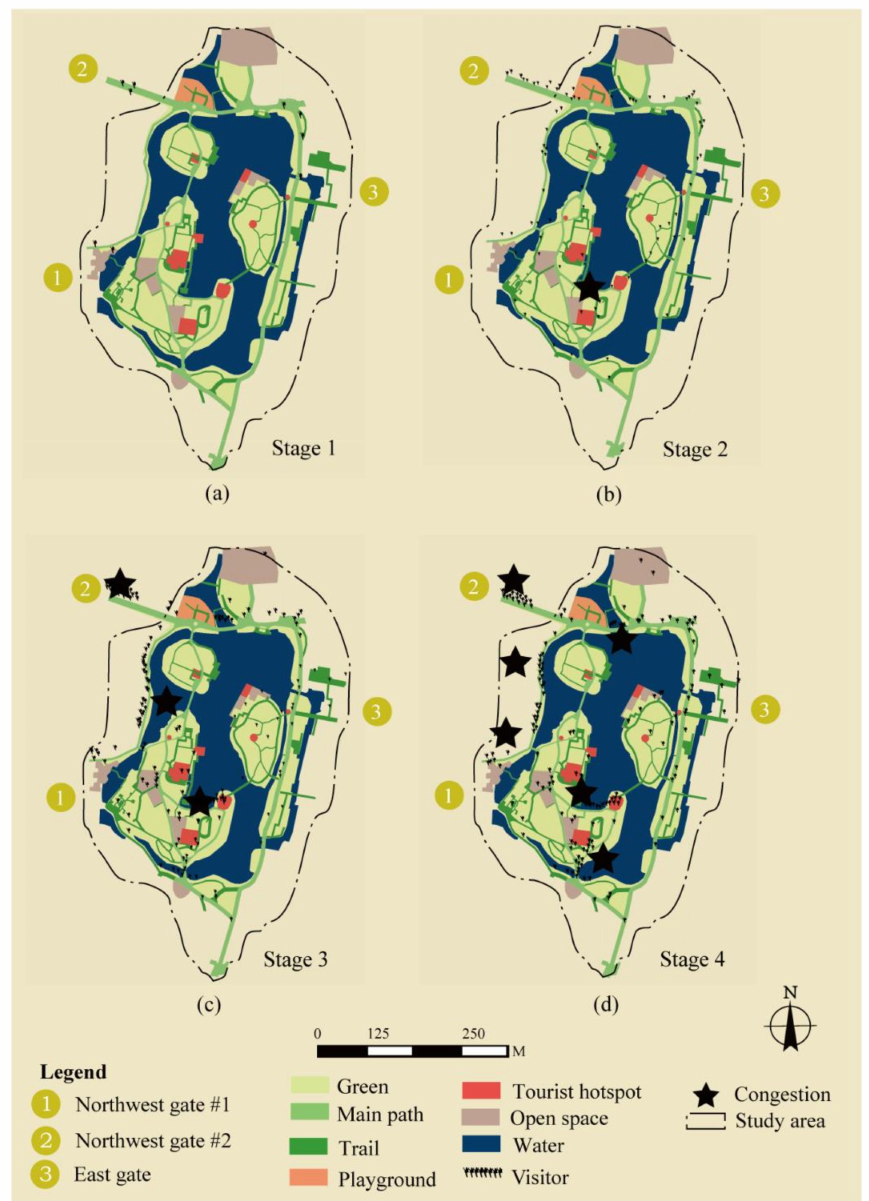
Figure 5. The four stages of congestion evolution in Bailuzhou Park. ( a ) is stage 1; ( b ) is stage 2; ( c ) is stage 3; ( d ) is stage 4.From ( a – d ), more users enter the park. There is no congestion in stage one but one congestion in stage two and more congestion in stage three until the entrance was blocked in stage four. Copyright 2020 © Author, all rights reserved, used by